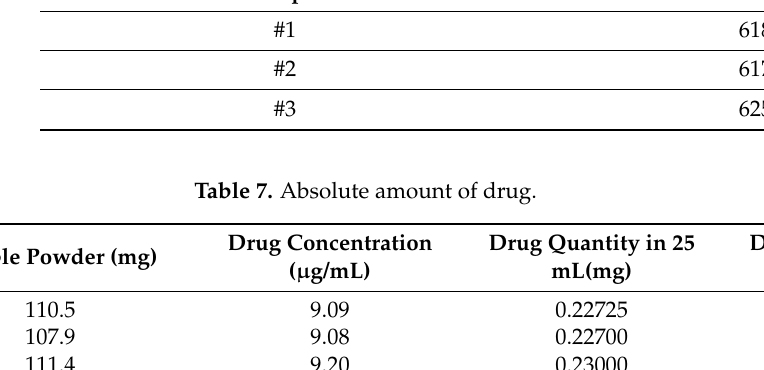
Table 7. Absolute amount of drug.